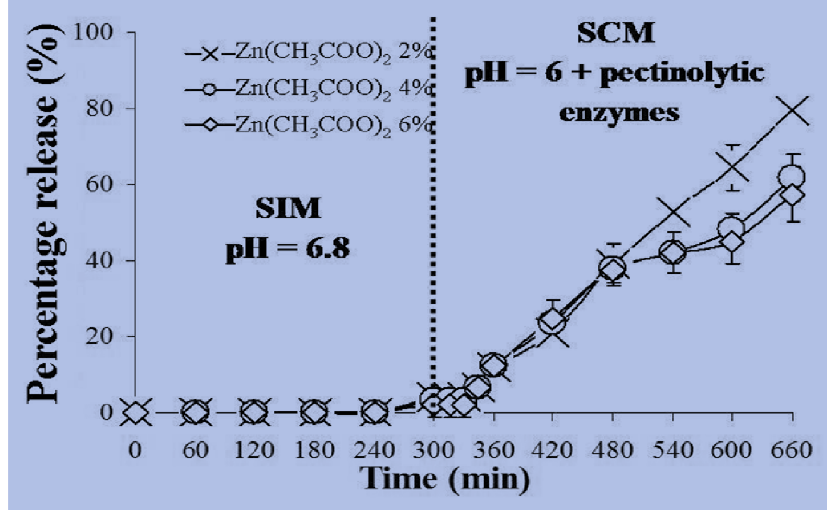
Figure 4. The release of MSKE from ZPG beads prepared with different concentrations of COO) (2, 4 and 6% w/v) determined after a 5 h-pre-incubation in SIM and a 6 h- Zn(CH 3 2 incubation in SCM containing pectinolytic enzymes (650 U/mL). Data are presented as the mean ± SD of three